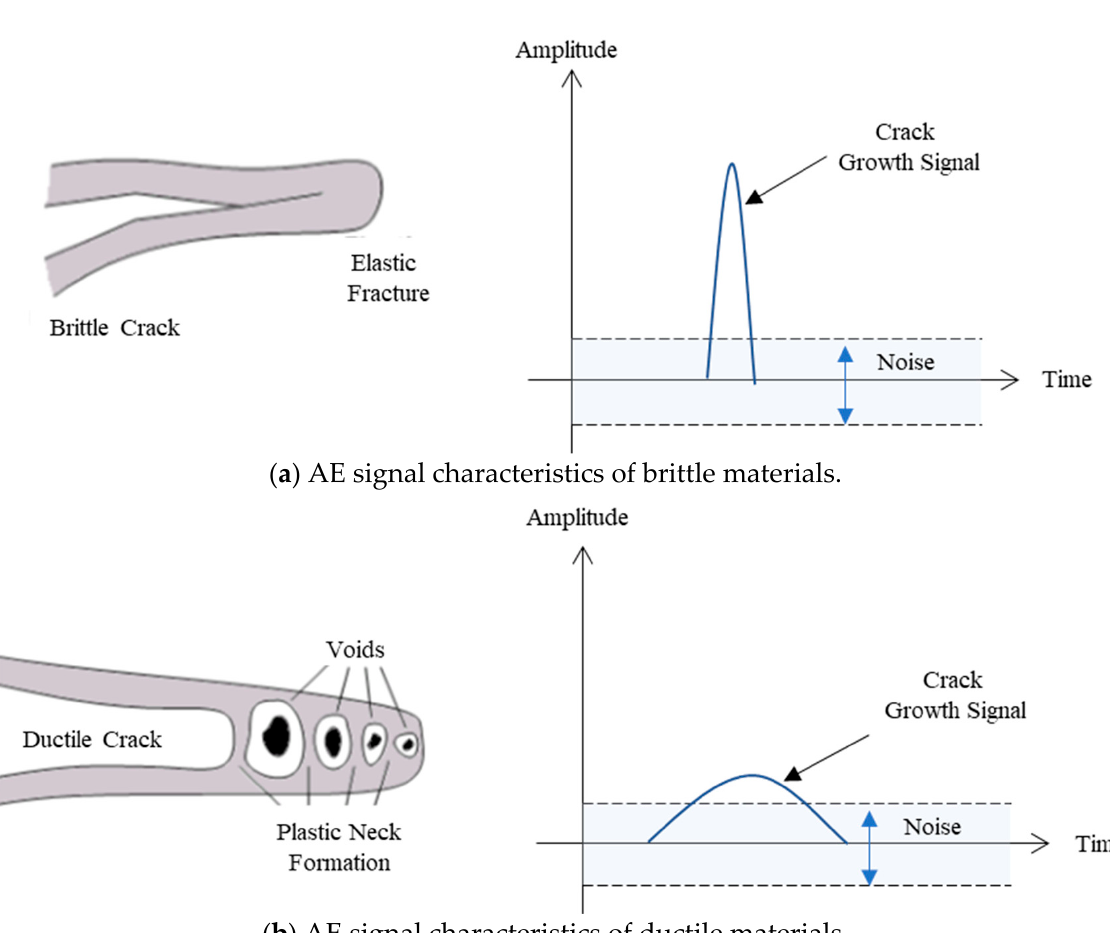
Figure 2. AE signal amplitude according to fracture characteristics.